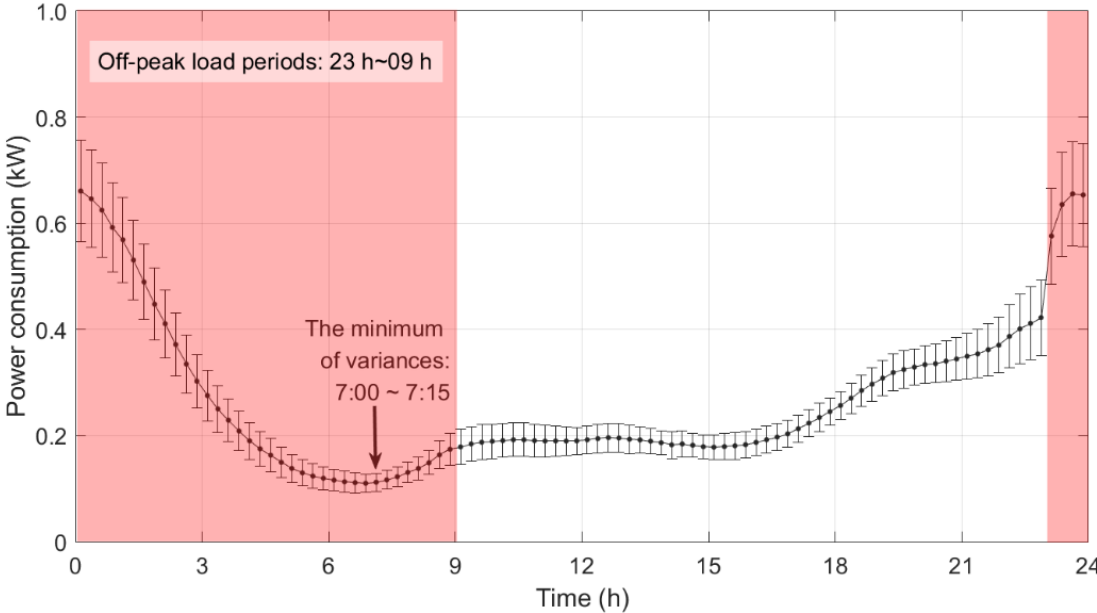
Figure 3. Variance analysis result of EVC charging demand data.